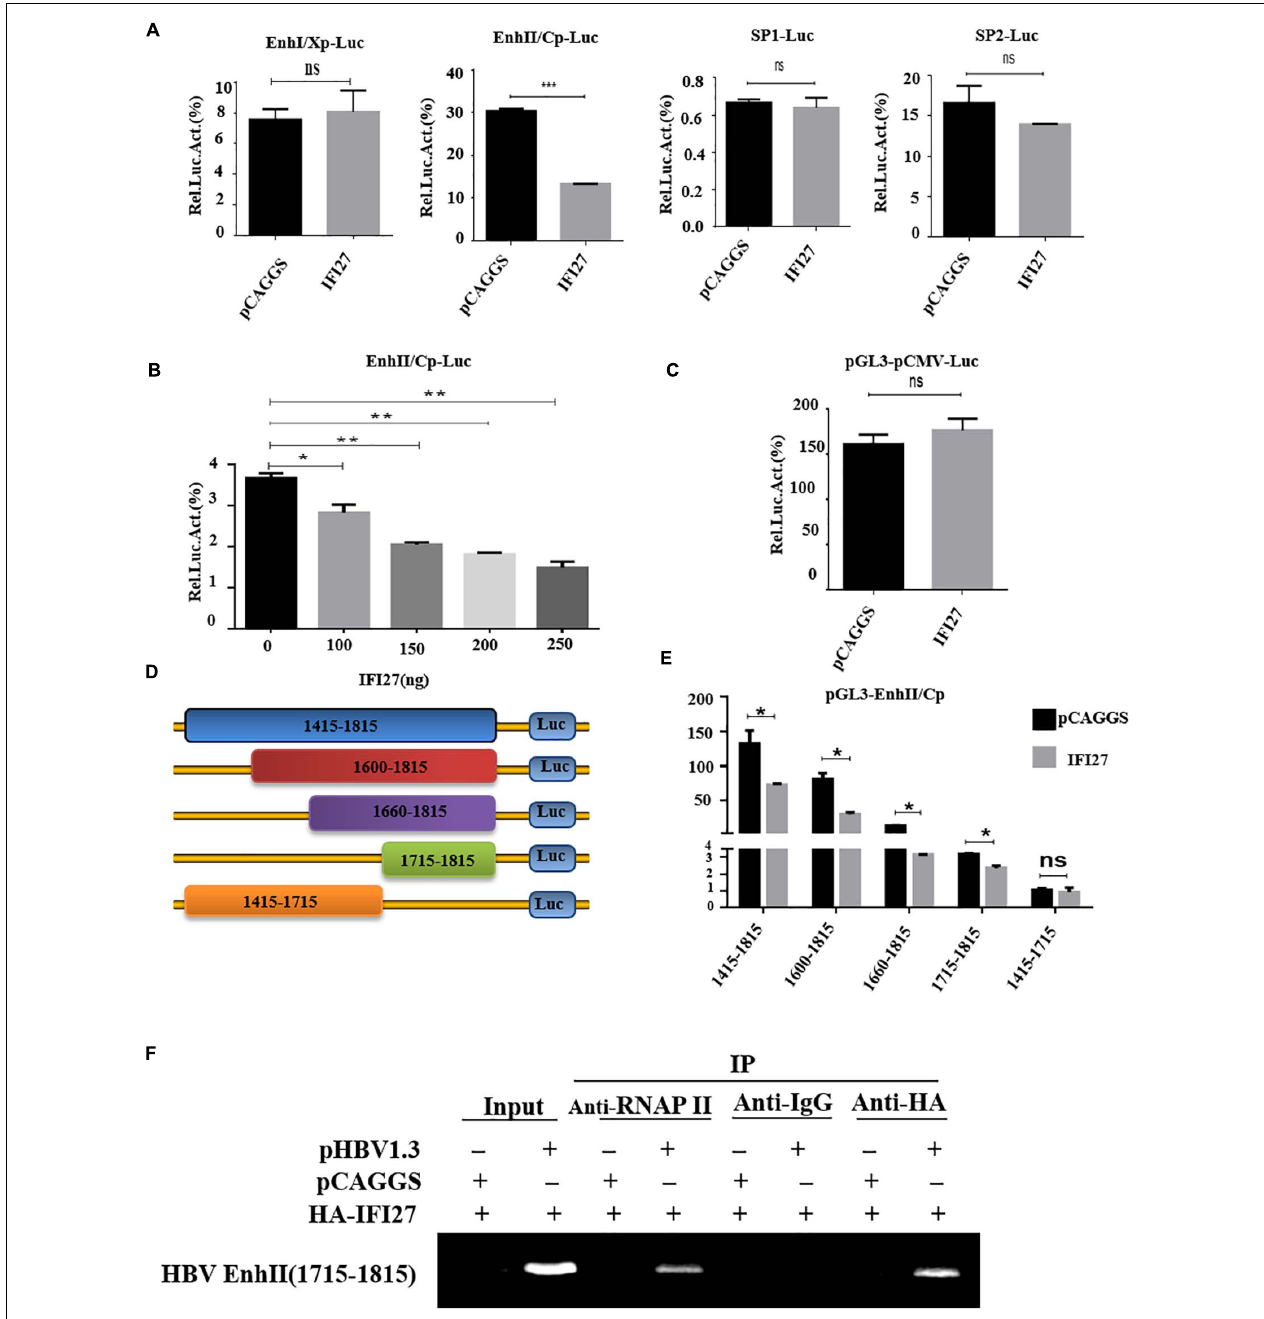
FIGURE 5 | IFI27 represses HBV gene expression by inhibiting EnhII/Cp promoter activity. (A) HepG2 cells plated in a 24-well plate were co-transfected with reporter plasmids pGL3-EnhI/Xp, pGL3-EnhII/Cp, pGL3-SP1, and pGL3-SP2 (200 ng each) together with pCAGGS-HA-IFI27 or pCAGGS (250 ng). Luciferase activities of Firefly relative to Renilla were determined. pRL-TK (50 ng) was used as a control of transfection efficiency. (B) HepG2 cells were co-transfected with reporter plasmid pGL3-EnhII/Cp-Luc and/or pCAGGS-HA-IFI27 or pCAGGS at different concentrations for 2 days (48 h). Luciferase assay was measured and normalized with control (pRL-TK). (C) HepG2 cells were co-transfected with pGL3-pCMV-Luc (200 ng) along with pCAGGS-IFI27 or pCAGGS. Luciferase assay was measured and normalized with pRL-TK. (D) The schematic diagram of serial deletion mutants of the EnhII/Cp reporter. (E) IFI27 and their effect on serial deletion of HBV EnhII/Cp promoter. (F) HepG2 cells were seeded in 10 cm dish and then co-transfected with pHBV 1.3 (5 µ g) and pCAGGS-HA-IFI27 or pCAGGS (5 µ g) for 48 h. The CHIP assay was achieved using an anti-HA antibody to examine the binding capacity of IFI27 to EnhII/Cp. The amplification of extracted chromatin DNA was done by PCR and determined by agarose gel electrophoresis. Normal IgG is used as a negative control (IgG), while RNA polymerase II acts as a positive control (RNAPII) in this experiment. * P ≤ 0.05, ** P ≤ 0.01, *** P ≤ 0.001 and ns (non-significant).